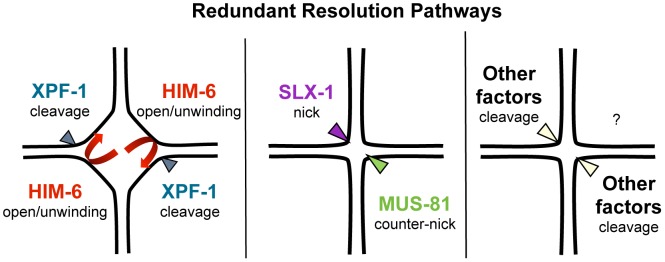
Model of redundant resolution pathways.